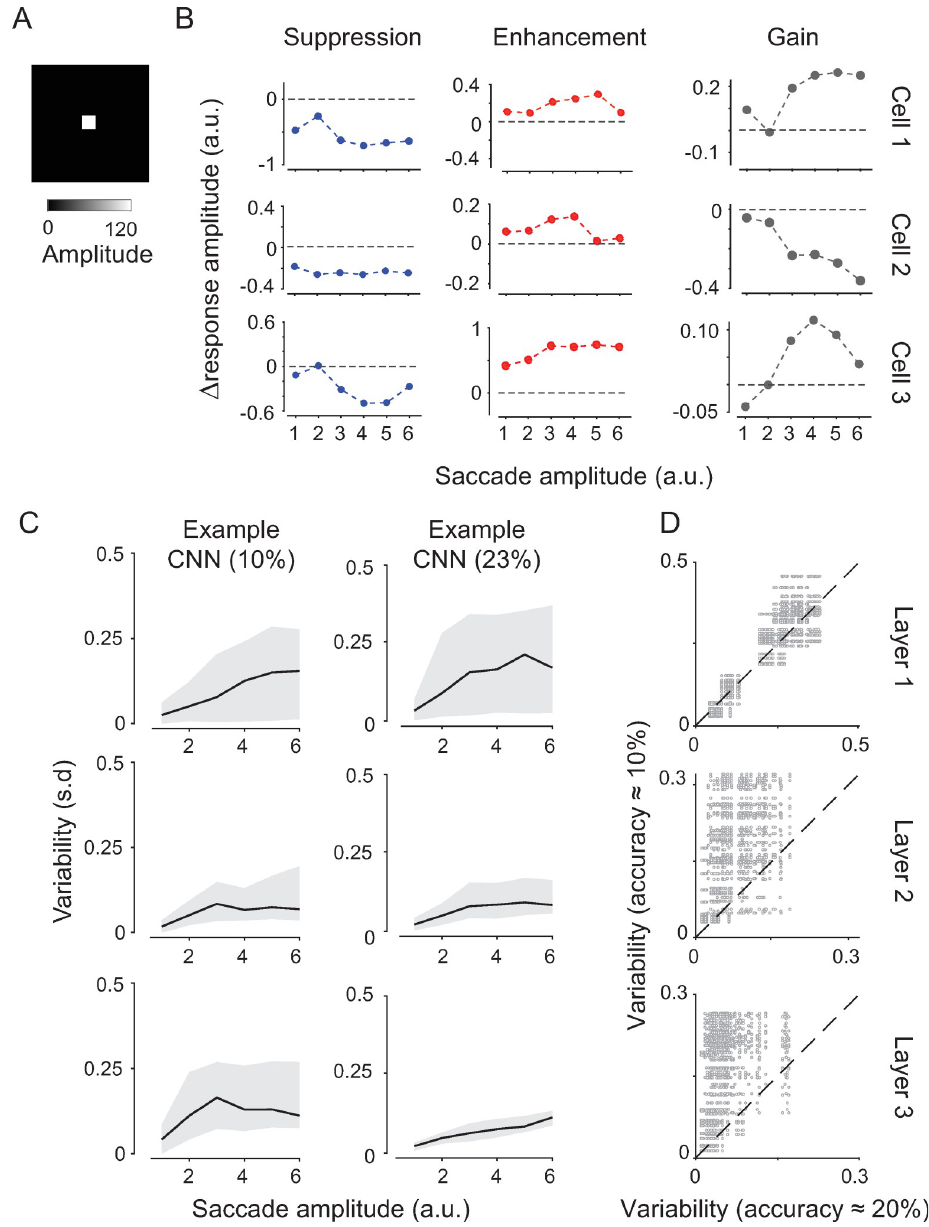
Fig 4. Saccadic modulation of single cell activations. (A) Test stimulus used to measure cell activations in the presence or absence of saccadic shifts. (B) Neurons showed diverse response modulations by saccadic inputs—that is, response change w/wo movement inputs (representative examples). For some neurons, responses were either overall suppressed or enhanced, largely independently from the amplitude of movement inputs (first two columns). For other neurons (third column), the response change was proportional to the movement amplitude; “gain” is used in reference to gain fields. Smallest to largest saccades grouped into six linearly spaced amplitude bins (Methods). (C), Variability in saccadic modulation across cells (s.d.) as a function of saccade size (x-axis) in different layers (rows) and for networks performing at chance level (left column) or above (right column). The solid line indicates the mean; gray band indicates the 5th-95th confidence interval (CI). (D) Scatter plot of maximum variability values (CI width, Methods) between networks at and above chance-level performance. Each dot refers to an example movement input.